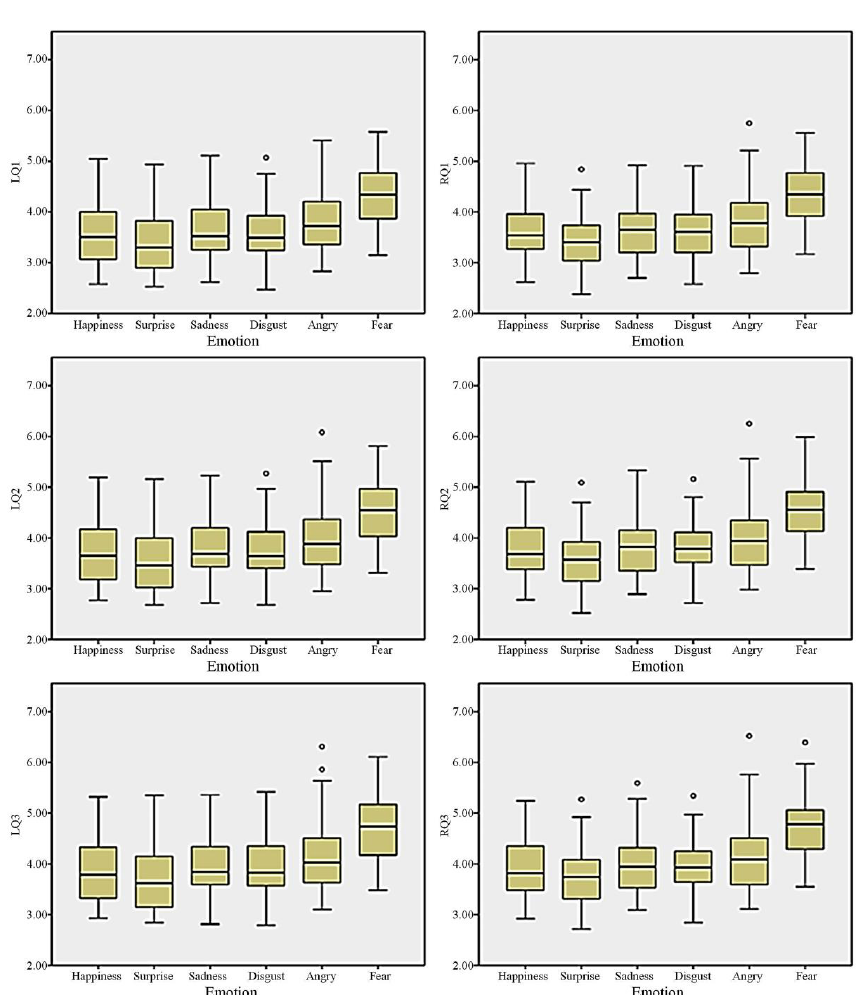
Figure 3. The averaged values of q1, q2 , and q3 for both eyes between six emotions. The cycles represent outliers, which are lower than q1 − 1.5 × interquartile range or higher than q3 + 1.5 × interquartile